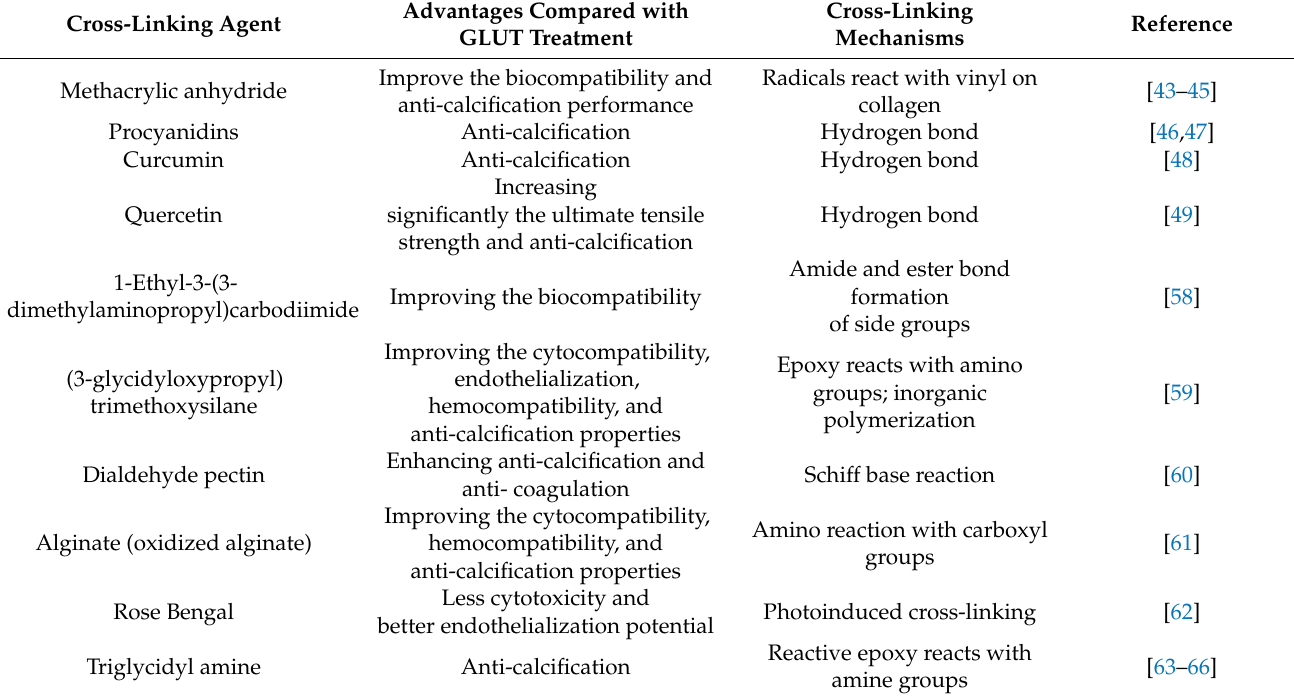
Table 1. Application of different cross-linking agents in the study of tissue-engineered heart